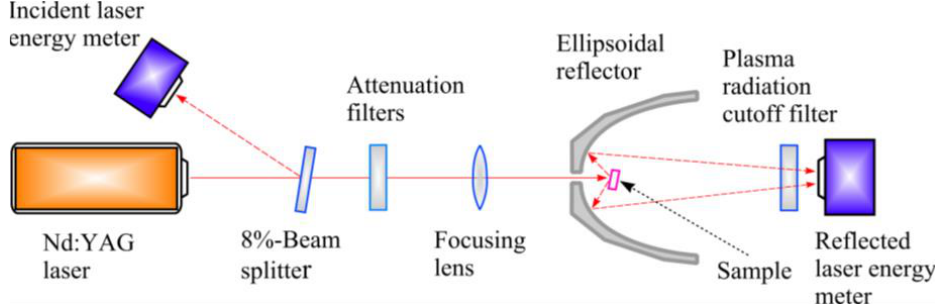
Figure 1. Experimental setup to study the reflection of laser light in niobium